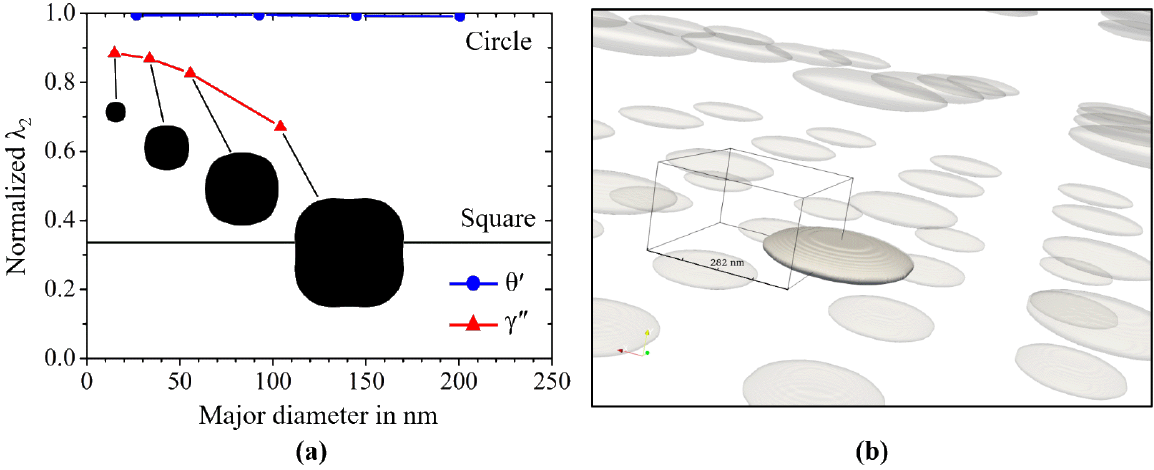
Figure 8. 3D simulation study on the in-plane particle shape under elastic particle–particle interaction at constant, realistic phase fractions. ( a ) Plot of the normalized λ 2 of the resulting in-plain shape of the θ′ precipitates compared to the values for the γ″ precipitates as a function of the major diameter; ( b ) For the visualization of the underlying simulation configuration, the resulting equilibrium shape of θ′ precipitate within the periodically extended-end system of elastically interacting particles is exemplarily shown.